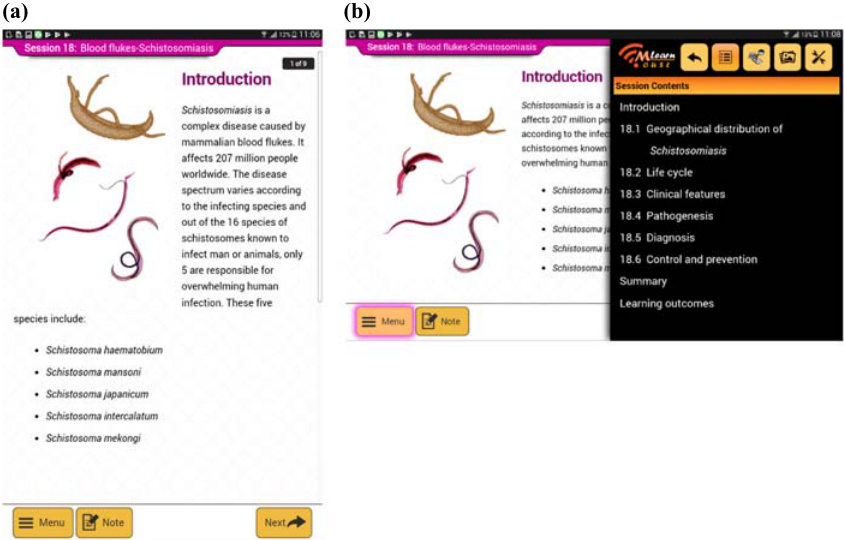
Figure 5. Program